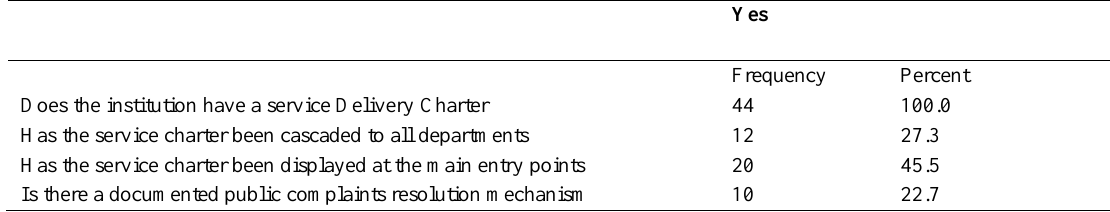
Table 5: Service Delivery in Institutions